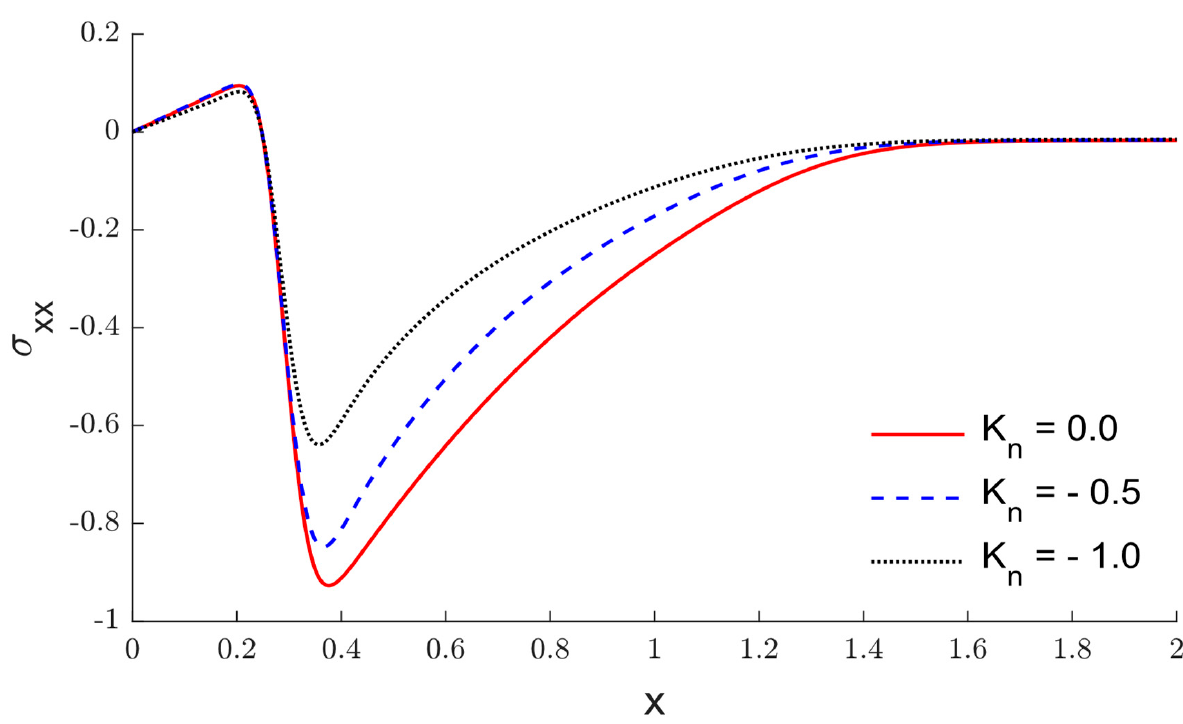
Figure 4. The impact of variable thermal conductivity and diffusivity in the stress variation σ xx via the distance x when τ o = τ 1 = 0.05.